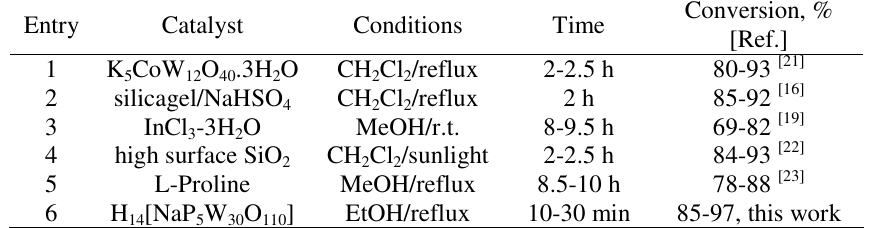
Table 2. Comparison of different catalysts reported in literatures for one-pot synthesis of 1,2,4,5-tetrasubtituted imidazoles